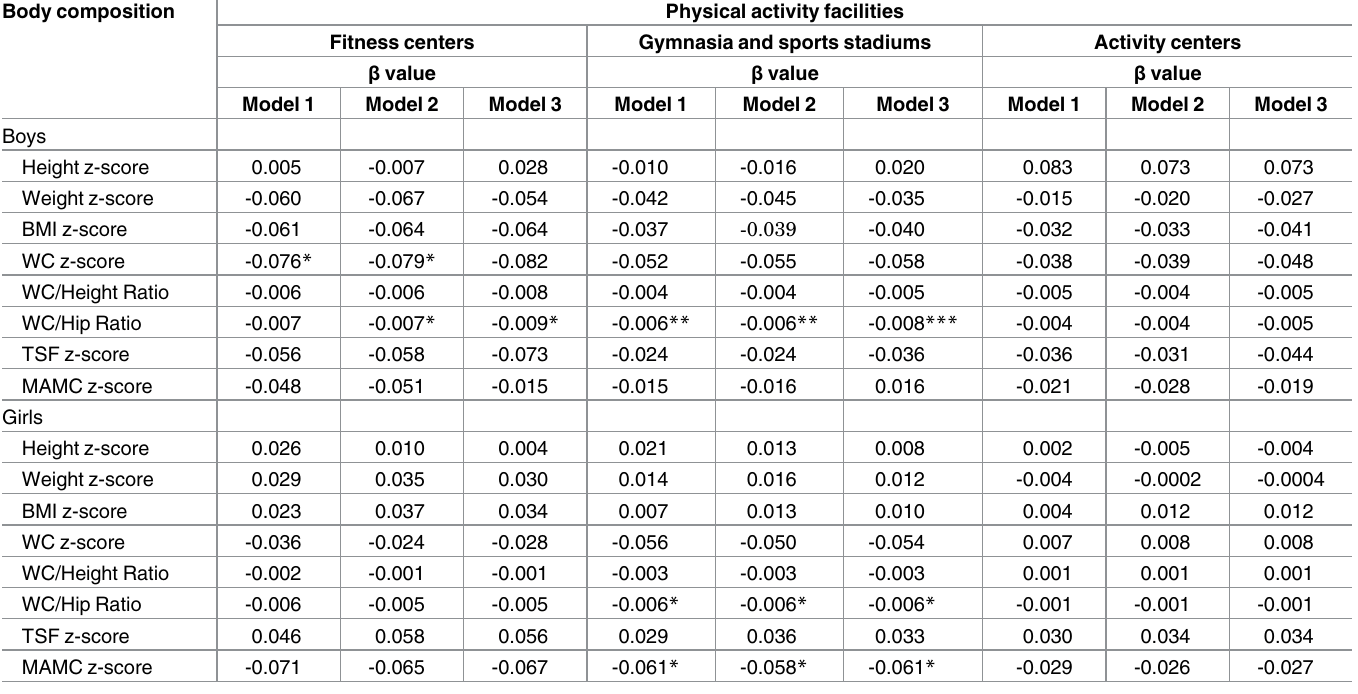
Table 4. Multiple linear regressions for body composition in relation to the physical activity facilities within 1000m a around junior high school by gender. Body